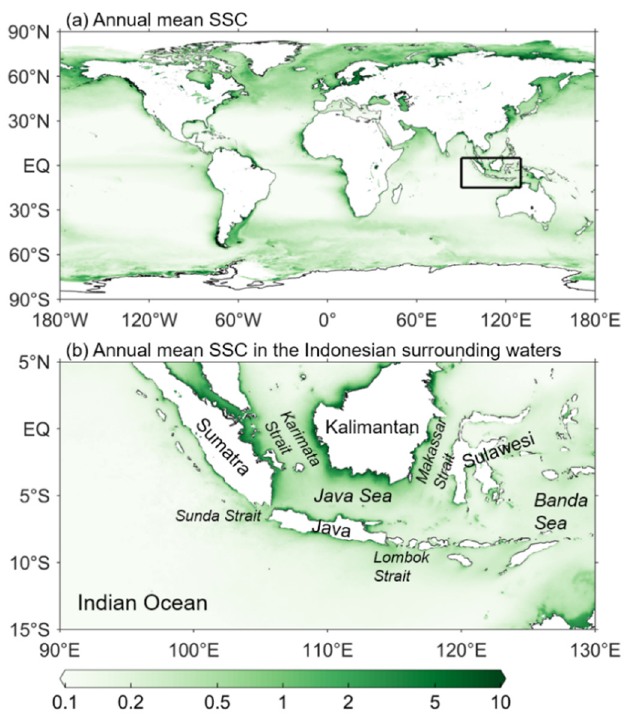
Figure 1. Distributions of annual mean SSC (mg/m 3 ): ( a ) global; ( b ) Indonesian surrounding waters. During the southeast monsoon seasons, the southeasterly wind along the